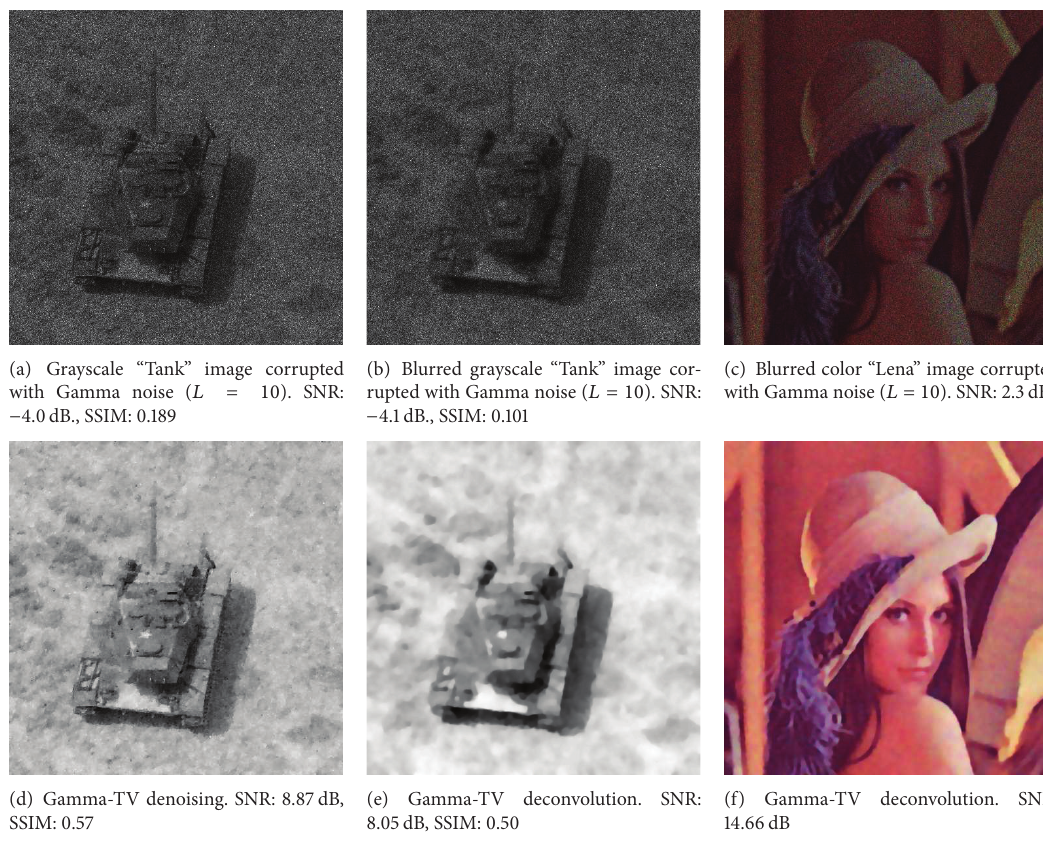
Figure 4: Denoising and deconvolution with the Gamma TV via [117]. Table 3: Denoising and deconvolution performance results for the Poisson-TV method for the grayscale “Cameraman” ( 512 × 512 ) image and the color “Peppers” ( 512 × 512 ) image.